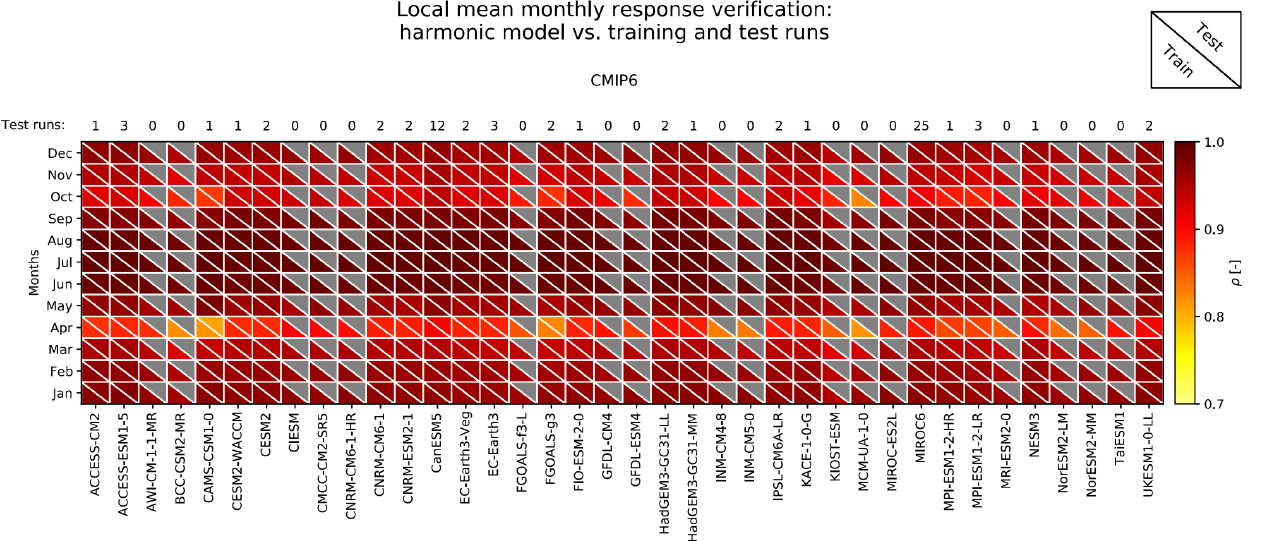
Figure 5. Local mean monthly response verification for all CMIP6 models by means of Pearson correlation between the harmonic model and training runs (indicated by the colour of the lower triangle), over all global land grid points (without Antarctica) for each month. The correlations between the harmonic model and test runs are given in colour in the upper triangles to demonstrate how well the harmonic model performs for data it has not seen yet (a grey upper triangle means that no test run is available for this model).